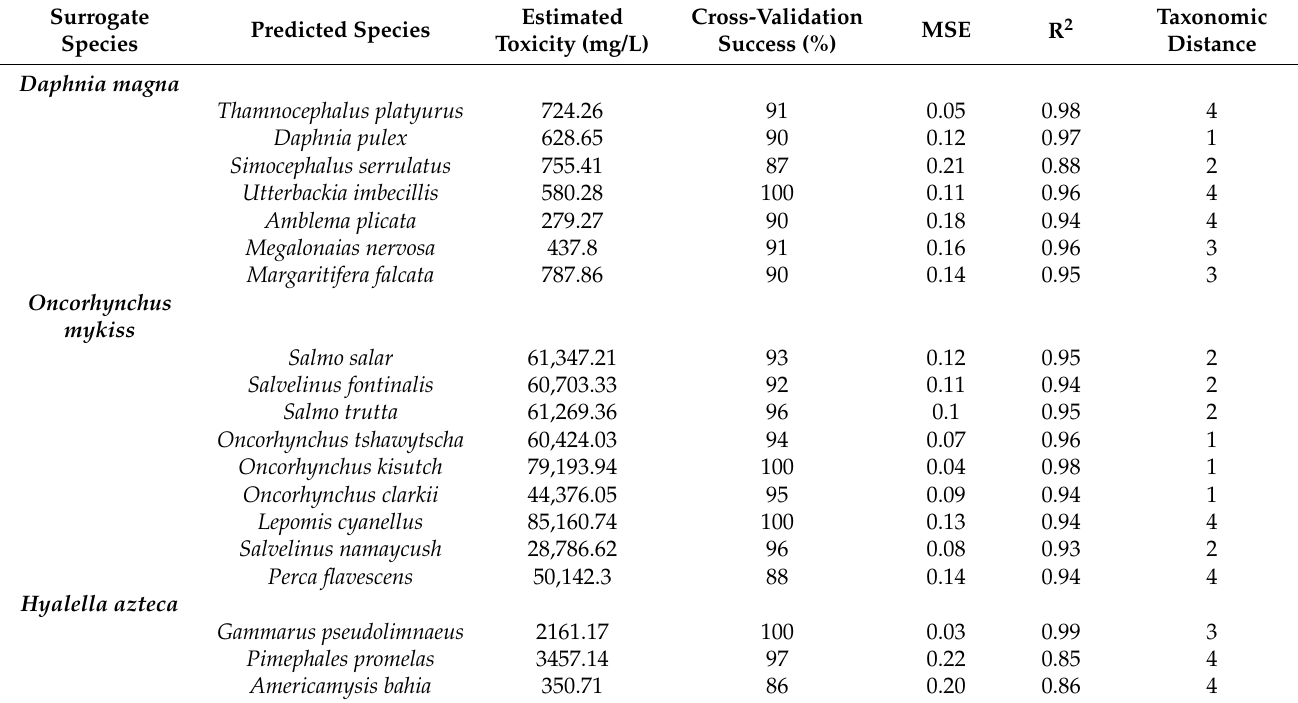
Table 2. Summary of the regression parameters of surrogate-predicted species using ICE